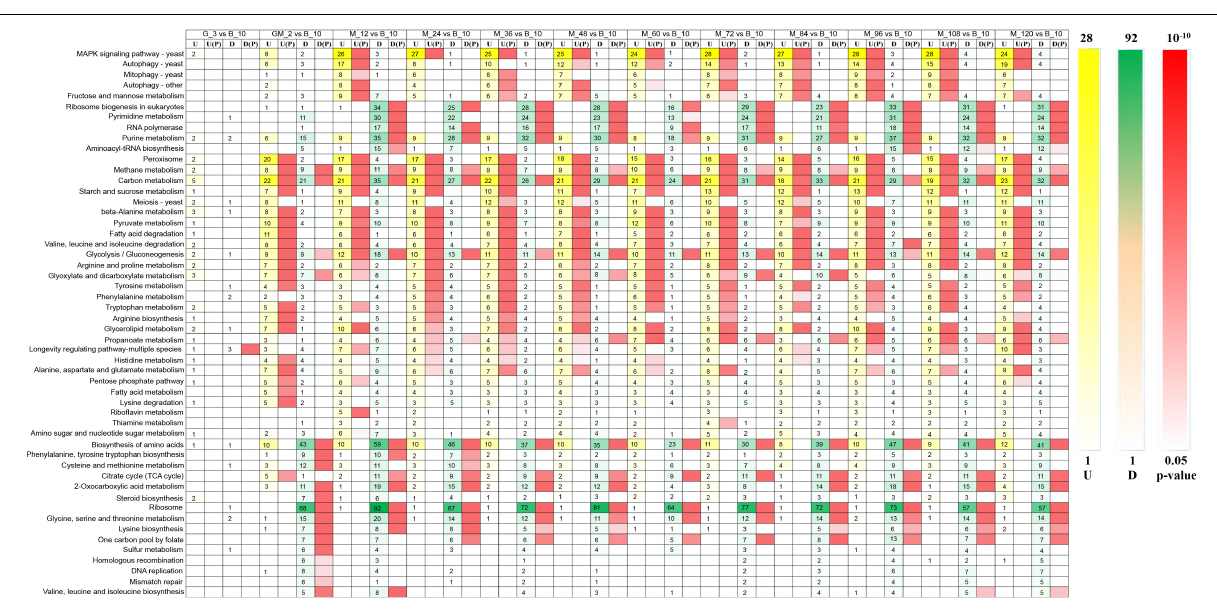
FIGURE 2 | Heatmap of upregulated and down-regulated genes that were significantly enriched in 52 metabolic pathways of Pichia pastoris . U, upregulated gene number, U(p): p -Value of upregulated genes enriched in metabolic pathway, D, down-regulated gene number, D(p): p -Value of down-regulated genes enriched in metabolic